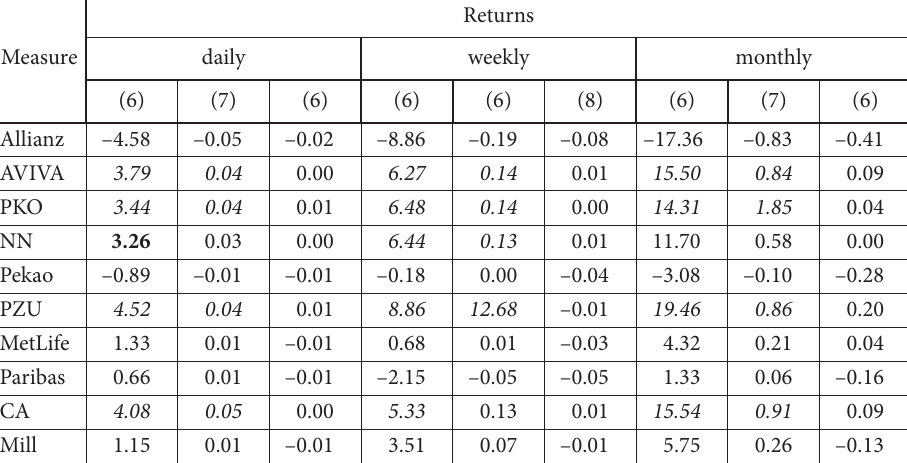
Table 15. Average values of Sharpe, Treynor and Jensen efficiency ratios evaluated for mutual funds for period d (source: own calculations)